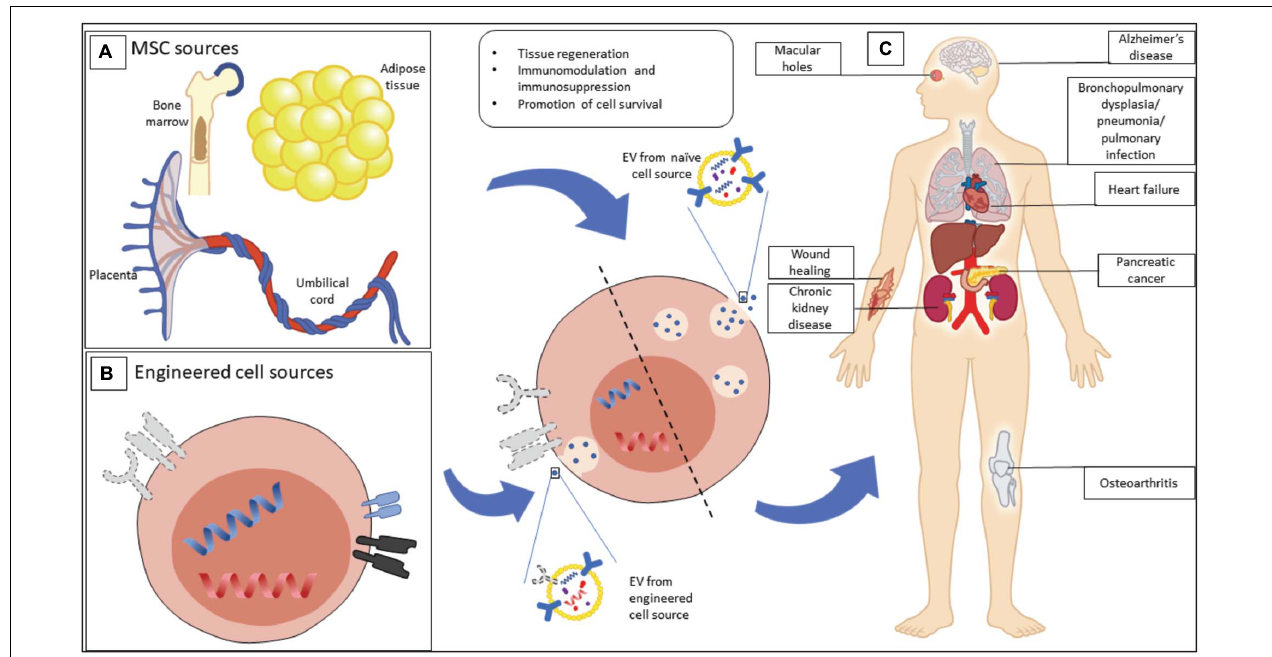
FIGURE 1 | Mesenchymal stromal cell (MSC) EVs have therapeutic potential for a range of possible indications. (A) MSCs, as a source of MSC-EVs, can be isolated from a wide range of tissues, including bone marrow, adipose tissue, and birth-associated tissue. (B) MSCs can be engineered in order to enhance their output of EVs, or to produce EVs with particular properties. (C) Beneficial properties of EVs from naive and engineered sources are being explored for a range of clinical